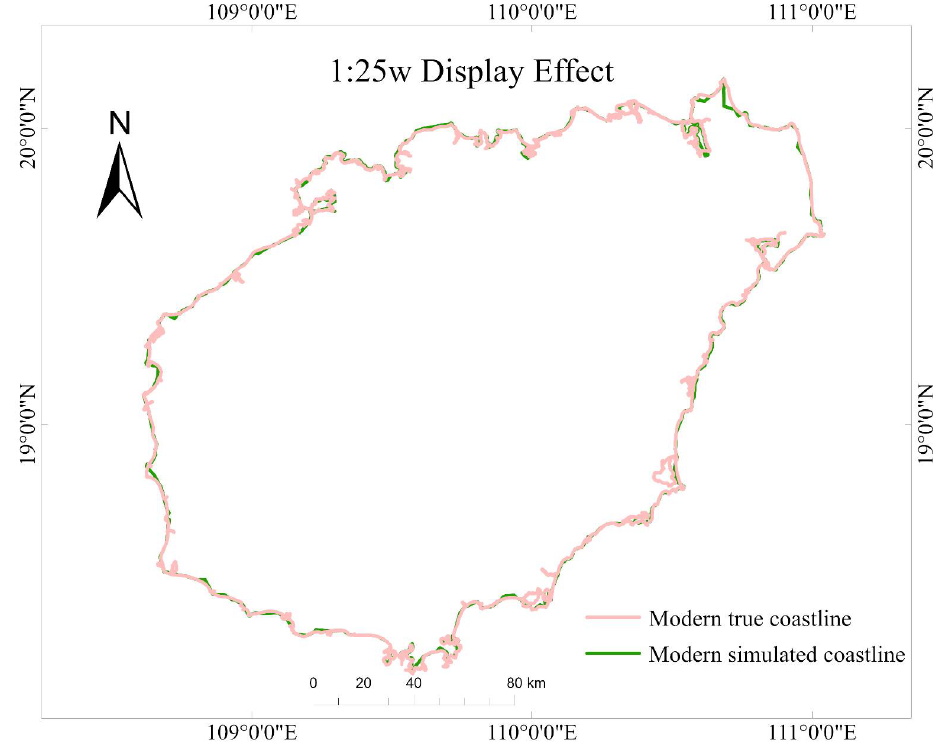
Figure 11. Display effect at 1:25w: the simulated coastline shows good results at the scale of 1:25w. After comparing the pre-founding coastline with the modern coastline, it was found Table 7. Place types in the south of Sanya: the top four types of changes in the total number of place names in Sanya in different